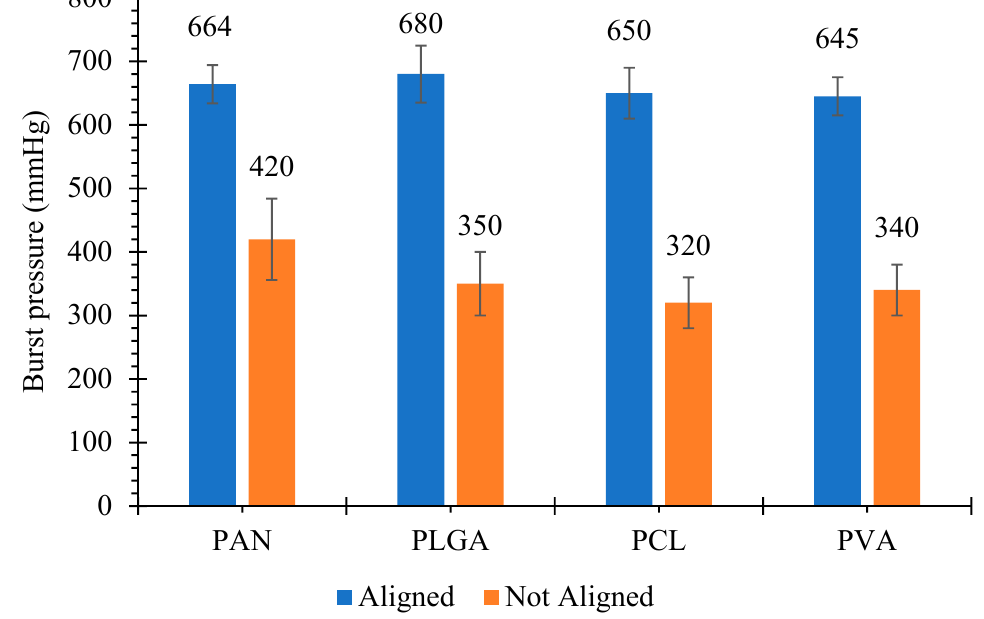
Figure 6. Burst pressure of cylindrical nanofibrous structures, with ‘aligned’ and ‘not aligned’